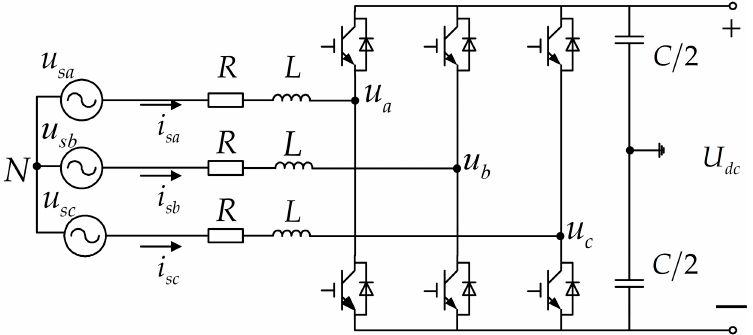
Figure 3. Structure of VSC.